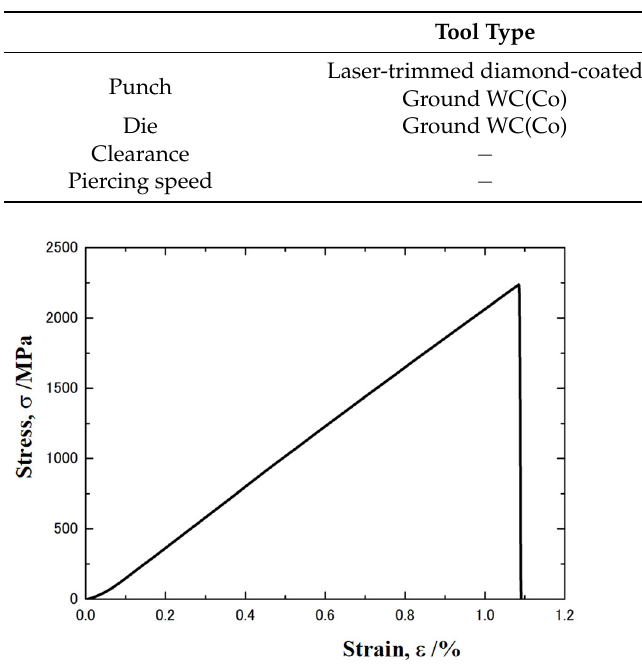
Figure 1. Stress-strain relationship of electrical amorphous steel sheets.